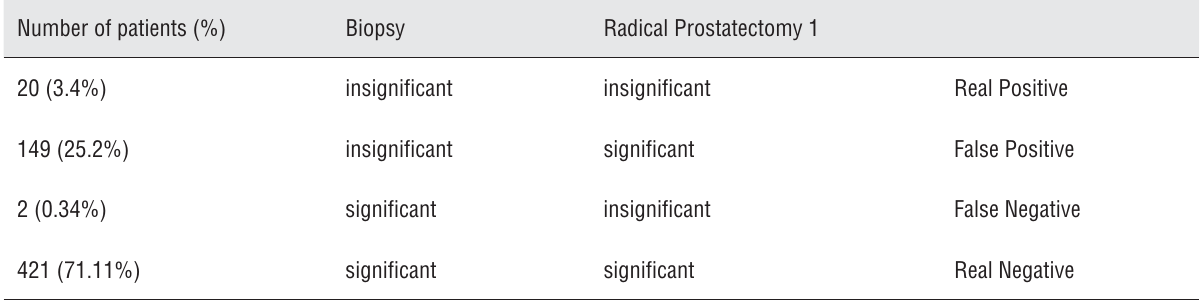
Table 1 - Comparison between biopsy and RP of the patients regarding clinical signifi cance of the tumor. Number of patients (%) Biopsy Radical Prostatectomy